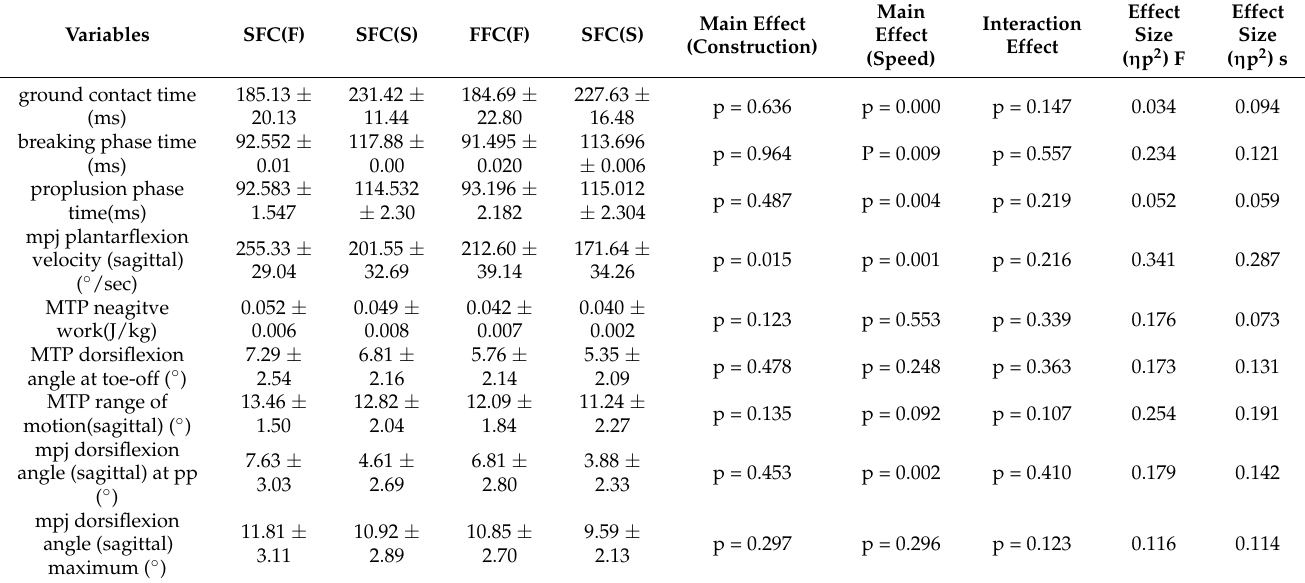
Table 2. The biomechanical variables for MTPJ and spatiotemporal parameters between SFC and